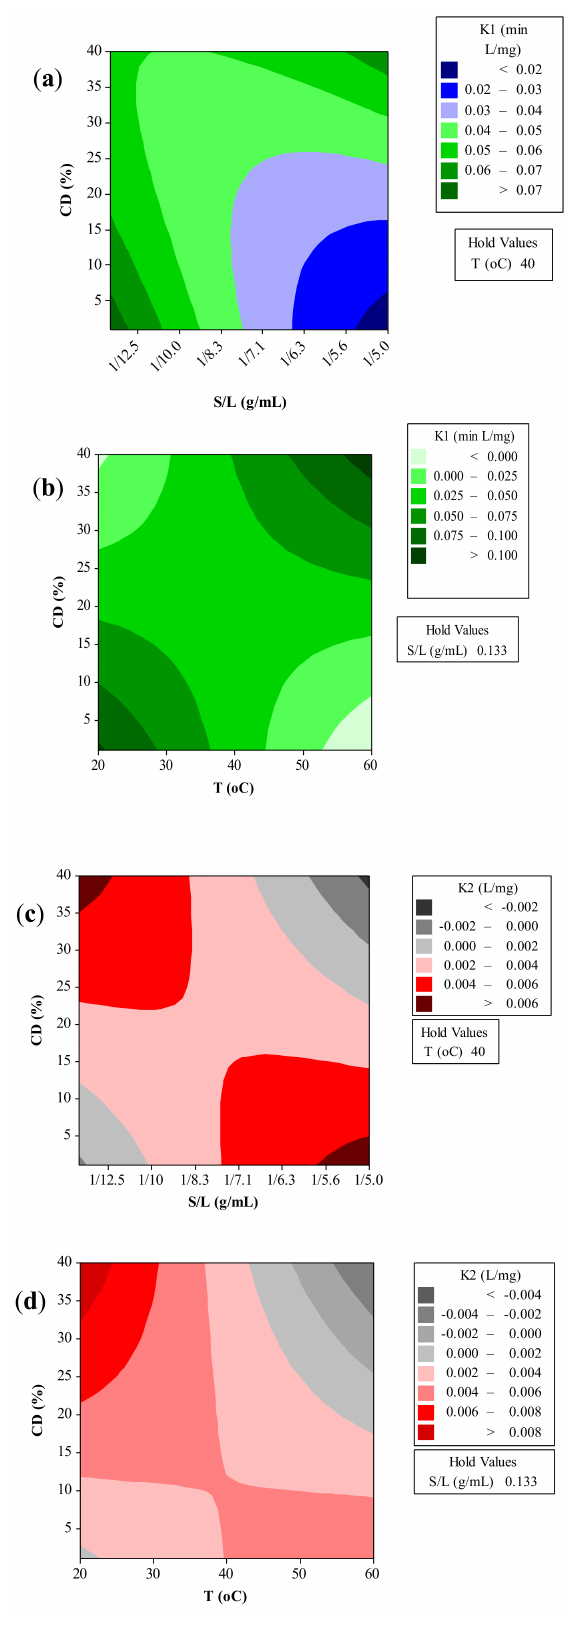
Figure 3. Contour plots illustrating the effect of extraction temperature ( T ), CD concentration ( C CD), and solid-to-liquid ratio ( S/L ) on the kinetic parameters K 1 ( a , b ) and K 2 ( c , d ) of the Peleg’s